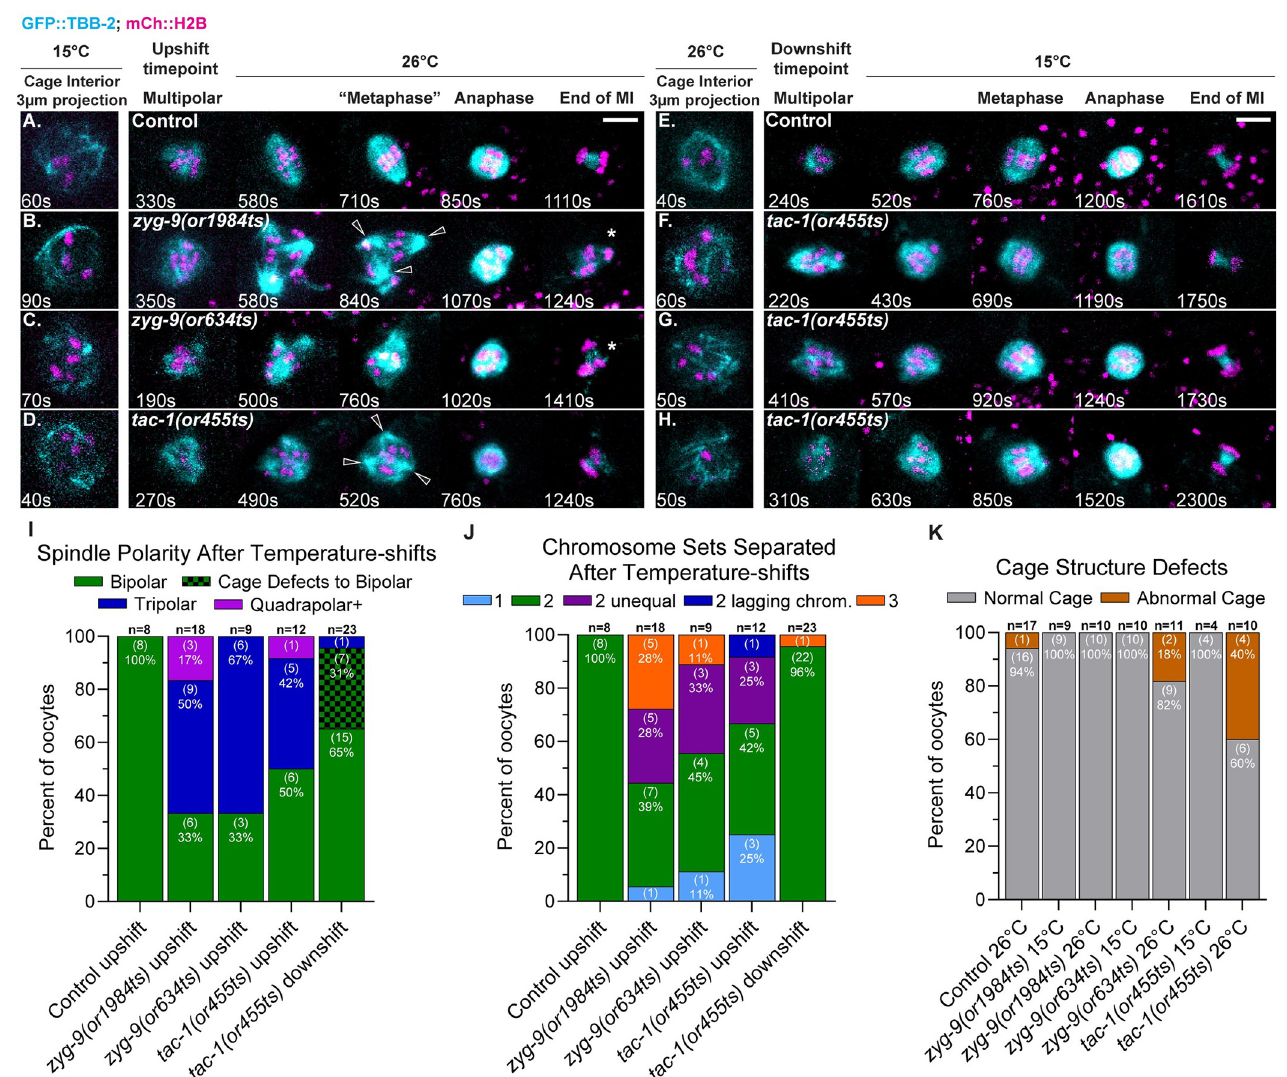
Fig 2. Pole coalescence and polarity defects in zyg-9 and tac-1 mutant oocytes do not depend on prior cage structure defects. (A-H) Time-lapse maximum intensity projection images of live control and TS mutant oocytes upshifted from 15˚C to 26˚C (A-D) or downshifted from 26˚C to 15˚C (E-H) during the multipolar stage, in oocytes expressing GFP::TBB-2 and mCherry::H2B. Oocytes depicted in F-H have cage structure defects (for 3-D images of TS mutant oocytes with cage stage defects, see S9, S10 and S11 Movies). Note that the cage stage images are maximum intensity projections of 3 focal planes (3 μ m) that encompass the dis-assembling nucleus, with limited resolution due to in utero imaging. All other images are maximum intensity projections of all 20 focal plans. For images of cage stage control and mutant oocytes that project all 20 focal planes, see S5 Fig. (I-K) Number of spindle poles present at the onset of spindle shortening per oocyte (I); number of chromosome sets separated during anaphase per oocyte (J); number of oocytes with abnormal cage structures (K); number of oocytes examined indicated above each bar, number scored with each phenotype shown in parentheses inside bars with corresponding percent below. Oocytes with extra spindle poles indicated with hollow arrowheads; oocytes with chromosomes separated into three sets indicated with asterisks. Bar graphs in (I) and (J) include oocytes expressing GFP::TBB-2 (this figure) and oocytes expressing GFP::ASPM-1 (Fig 4). Scale bars = 5 μ m.